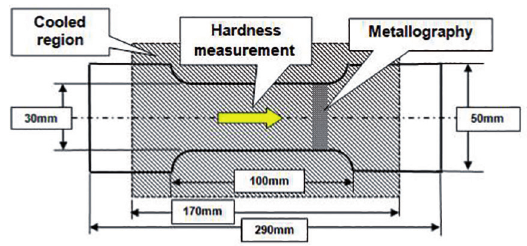
Figure 2: Test specimen showing cooling region and sampling details.